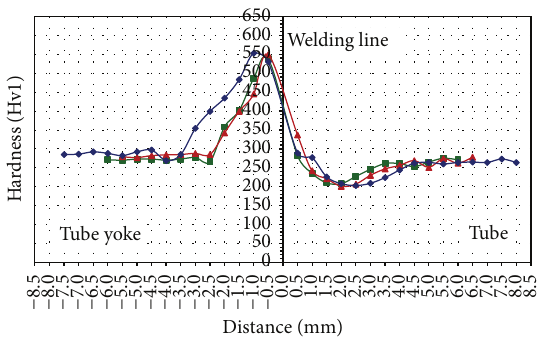
Figure 7: Microstructure of the welding zone. Figure 8: Hardness distribution along the